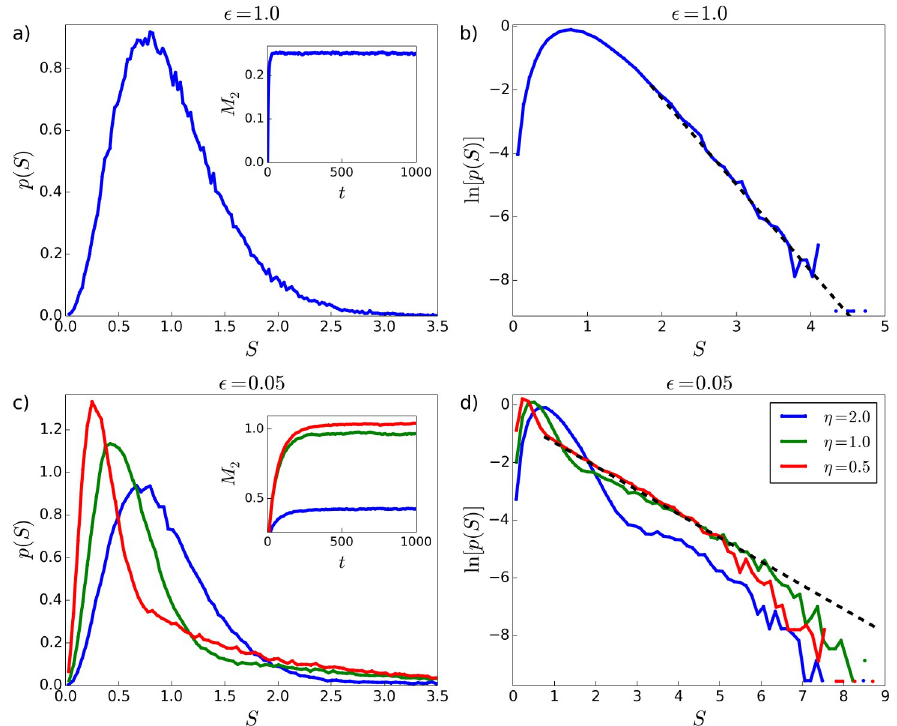
Fig 7. Status distributions in the extended model. δ = 0.2 and α = 0 in all plots. Plots (b) and (d) show the distributions on a logarithmic scale, in order to allow for inspection of the large- S tail. When � is decreased from 1, a “break” in the distribution emerges, (particularly evident on the logarithmic scale) corresponding to a society with distinguishable low status and high status groups or classes. The black dashed lines in (b) and (d) are maximum likelihood fits of exponential distributions with lower-bound at S = 2.25 in (b) and [lower-bound, upper-bound] at S = [0.75, 5.0] in (d), where plotted fit line in (d) is extrapolated beyond S = 5.0. System size N = 10 5 .